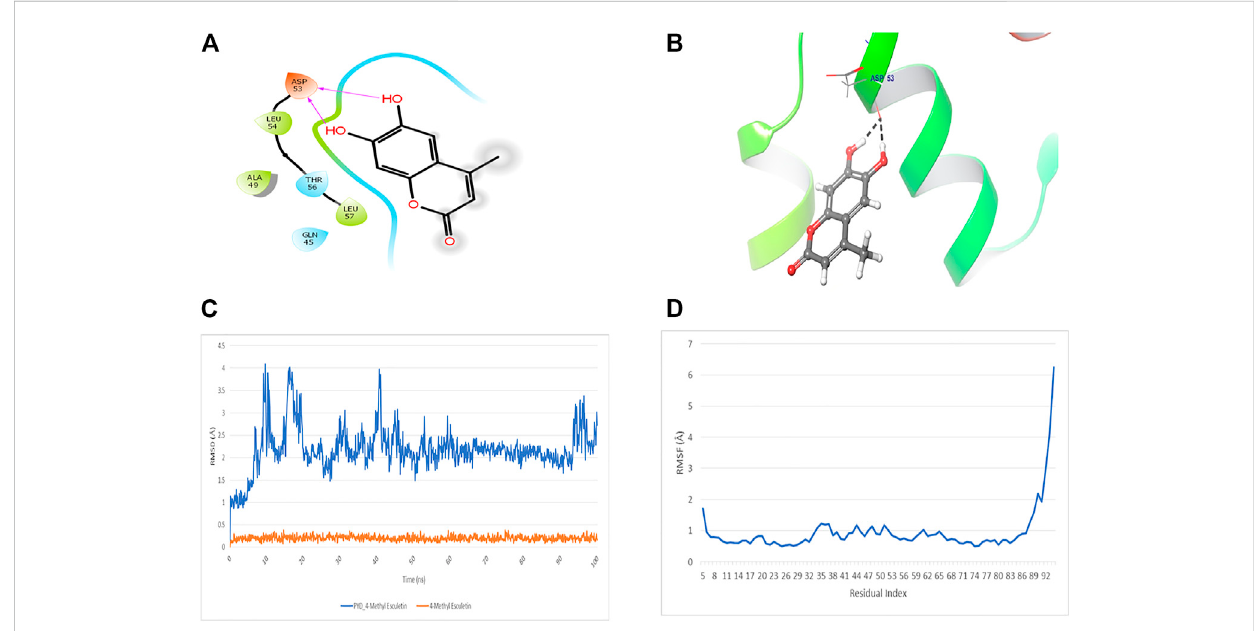
FIGURE 1 DockingandMDsimulationstudyof4-MESCwithNLRP3PYD. (A) 2Dimageofbindingpositionof4-MESCwithinthebindingpocketofNLRP3PYD. (B) 3Dimage. (C) RootmeansquaredeviationoftheC- α backboneofNLRP3PYDafterbindingwith4-MESC. (D) Rootmeansquare fl uctuationoftheC- α backbone of NLRP3 PYD after binding with